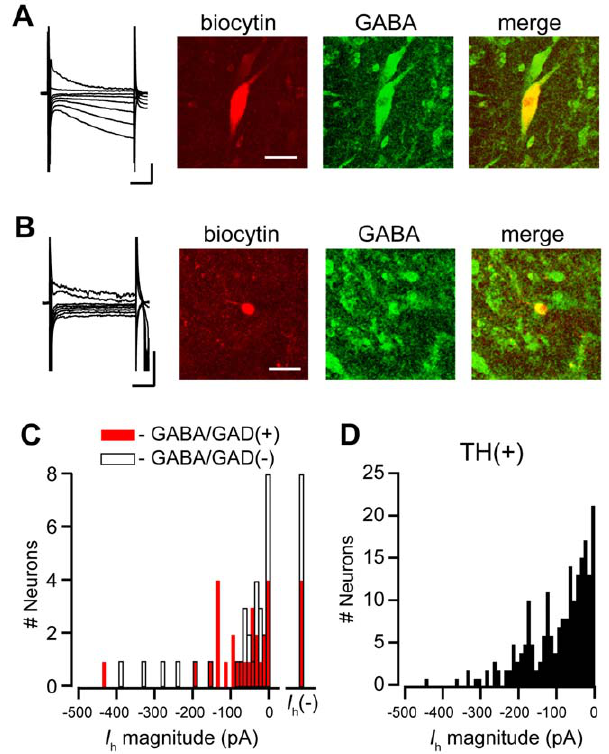
Figure 5. Most VTA GABA neurons are I h ( + ). (A) Example GABAergic neuron that has a large I h (far left, scale bars: 100 pA and 50 ms). The neuron was filled with biocytin (left; red; scale bar: 20 m m) and immunocytochemically confirmed GABA( + ) (middle, green). (B) Example I h ( 2 ) GABAergic neuron (far left, scale bars: 50 pA and 50 ms) that was filled with biocytin (left; scale bar: 20 m m) and confirmed GABA( + ). (C) Histogram of I h magnitudes measured in GABA/GAD( + ) and GABA/GAD( 2 ) neurons. (D) For comparison, histogram of I h magnitudes from recorded VTA dopamine neurons identified with TH immunocytochemistry.